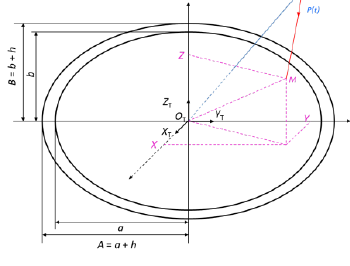
Figure 1. Ground point calculation by space It can be deduced according to Eq.(3):